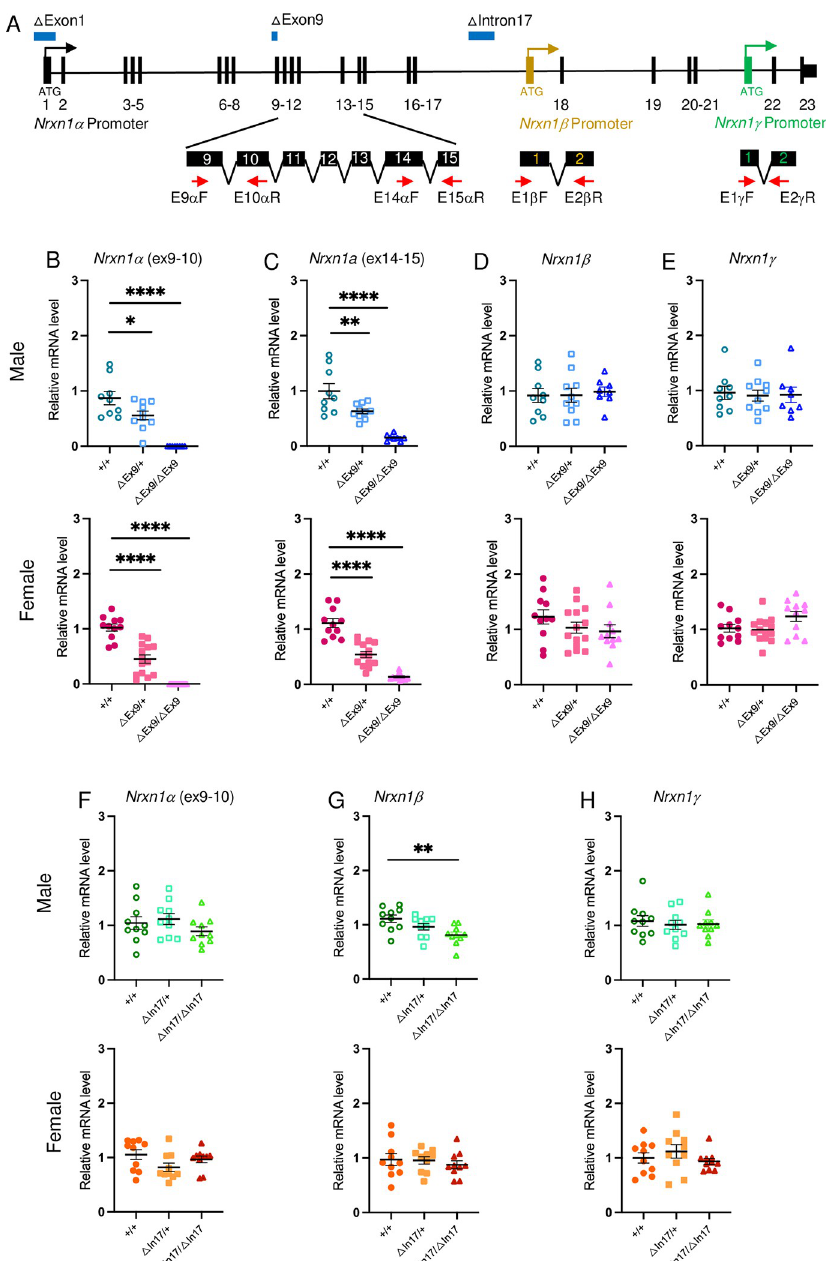
Fig 1. Diagram illustrating Nrxn1 allelic series and examination of Nrxn1 isoform specific expression. A. Genomic organization of the mouse Nrxn1 gene. Exons are labeled with vertical lines and numbers. Three different promoters driving Nrxn1 isoform-specific transcription are indicated with differently colored arrows. The Nrxn1 β specific exon is labeled with a brown vertical line and the Nrxn1 γ specific exon is labeled with a green vertical line. Translation start site, ATG, for each isoform-specific protein translation, was labeled under each isoform-specific exon. The positions of primers used for quantitative RT-PCR are indicated below enlarged exons (black bars) with red arrows. The genomic positions for promoter/exon 1 deletion ( Δ Exon1), exon 9 deletion ( Δ Exon9), and a ~20kb deletion in intron 17 ( Δ Intron17) are marked with blue bars on top of the Nrxn1 gene. B-E. Quantitative measurement of Nrxn1 isoform specific mRNAs in the Δ Exon9 mouse line (top row for males and bottom row for females). (B) Nrxn1 α mRNAs containing the exon 9 sequence is decreased to about 50% in Δ Exon9/+ mice and 100% in Δ Exon9/ Δ Exon9 mice compared to +/+ WT controls (Exon9 labelled as Δ Ex9). (C) Nrxn1 α mRNAs are reduced to about 50% in Δ Exon9/ + and nearly 100% in Δ Exon9/ Δ Exon9 mice compared to +/+ WT controls. Nrxn1 β (D) and Nrxn1 γ (E) mRNAs are not altered in mice carrying Δ Exon9/+ or Δ Exon9/ Δ Exon9 in comparison to +/+ (WT). For panels of Δ Exon9